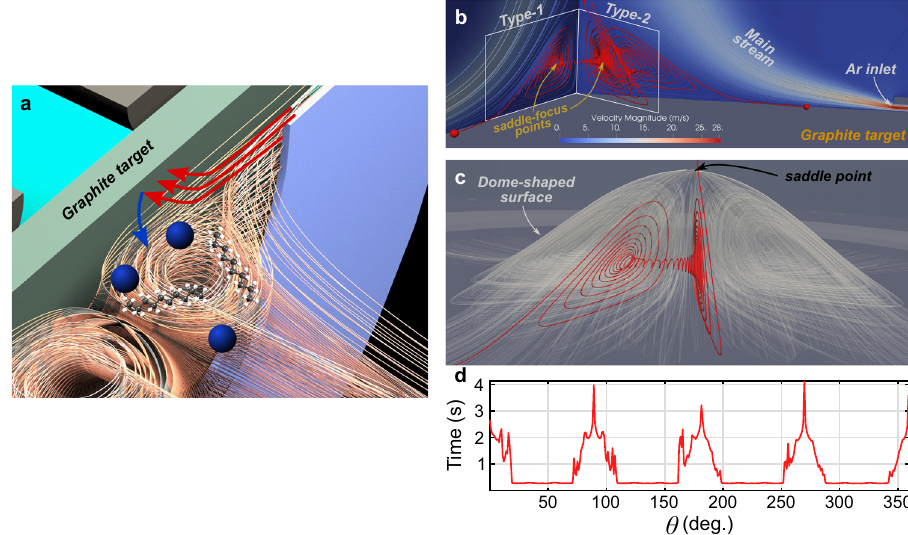
Fig. 4 Trap-and-release fl ow mechanism at the magnetron head. a General schematic of the magnetron head: orange lines represent the main Ar stream. Detail of the Ar + ion impact (red arrows) toward the graphite target and the possible trajectory of knock out C atoms ejected toward the attraction areas (blue arrow), where gas-phase C – C coupling occurs to form C-NPs (blue spheres) and alkane chains (not at scale). b , c Torodial sectional streamlines ( b ) and the stable manifold of the saddle point ( c ) in the region close to the graphite target. Trap-and-release events for C atoms released in the fl ow are shown by red streamlines. d Residence-time distribution as a function of azimuth along the injection ring. This distribution is computed for fl uid trajectories originating from a circular ring of initial conditions with a uniform grid spacing along the azimuthal and radial directions,